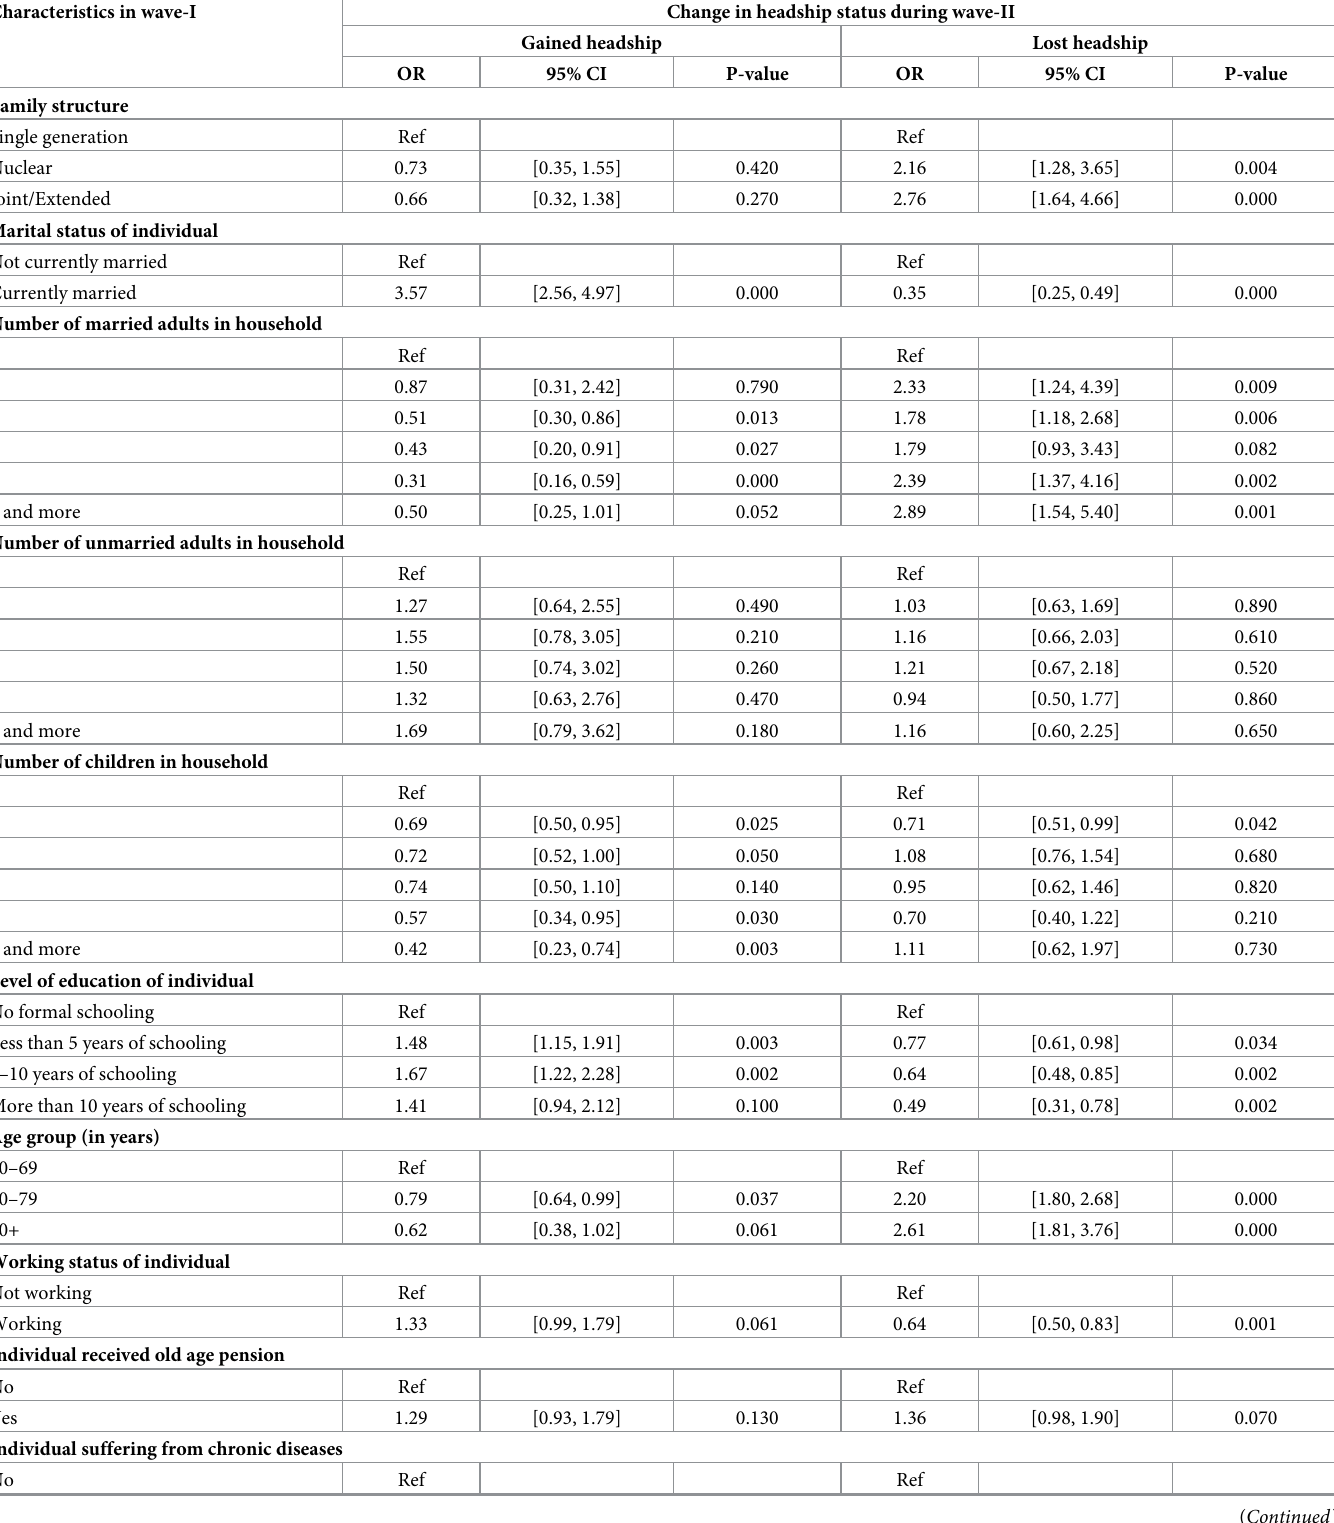
Table 3. Logistic regression estimates of socio-economic and demographic characteristics in wave-I with gain and loss in headship in wave-II. Characteristics in